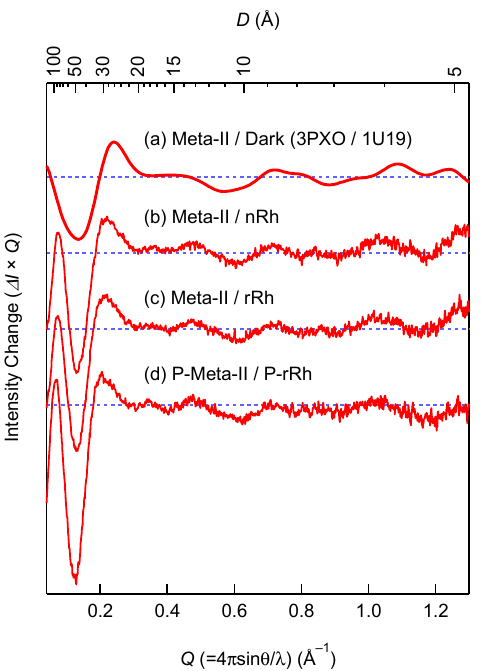
Figure 1. WAXS profile changes during Meta-II formation. ( a ) Calculated curve by CRYSOL [23], using the crystal structures of Meta-II (3PXO) [18] and the dark state (1U19) [24]. Diffrence WAXS curves between Meta-II and the dark state that are measured using ( b ) nRh/ND, ( c ) rRh/ND, and ( d ) P-rRh/ND.